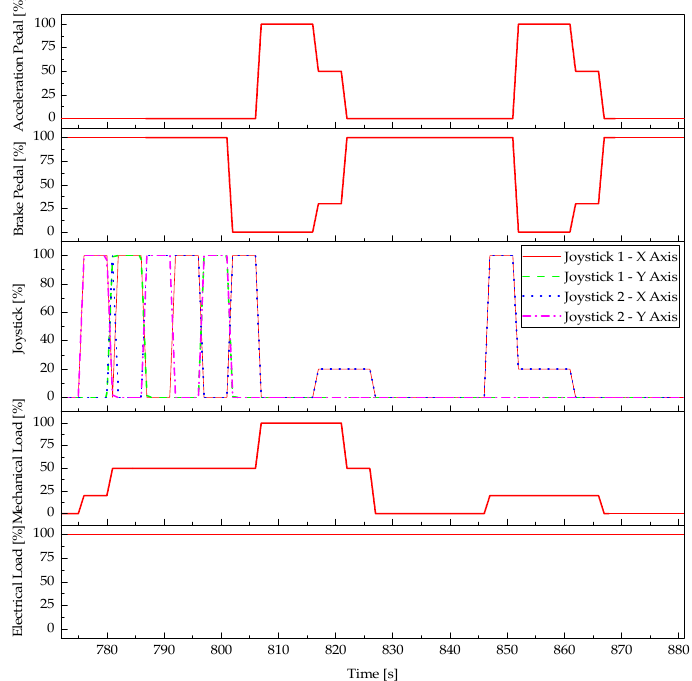
Figure 16. Simulated HMI and load signals from the 7th cycle—stage 16 to the 8th cycle—stage 15.